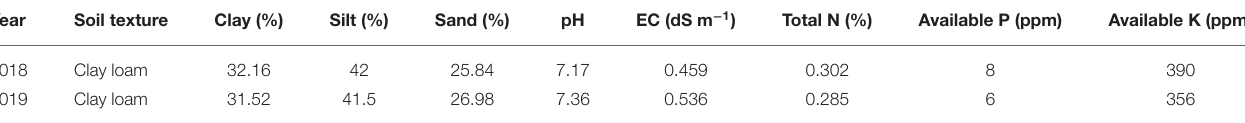
TABLE 2 | Some physical and chemical properties of the soil of experimental